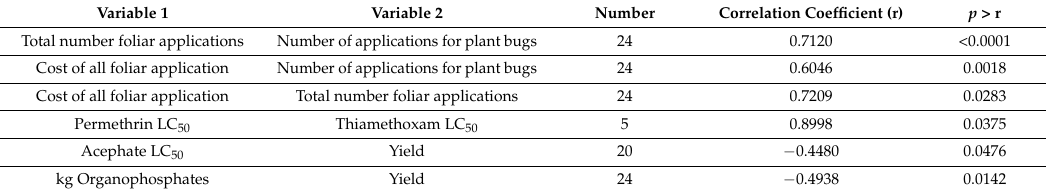
Table 11. Significant correlations observed between measured LC 50 s, estimated insecticide use per acre of harvested cropland, and cooperative extension service estimates of cotton insect losses and control costs for